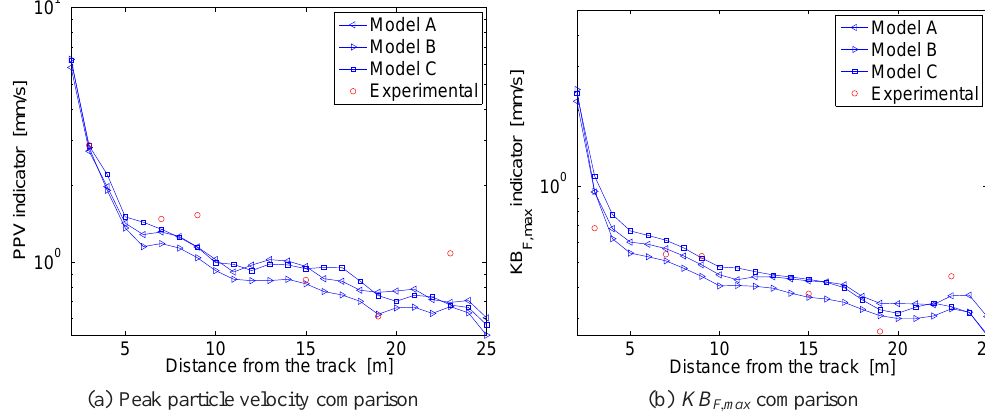
Figure 18. Overview of the ground vibration level di ff erence for various distances from the track. simple power–law function PPV ∝ d − 0 . 7 KB F , max ∝ d − 0 . 5 .